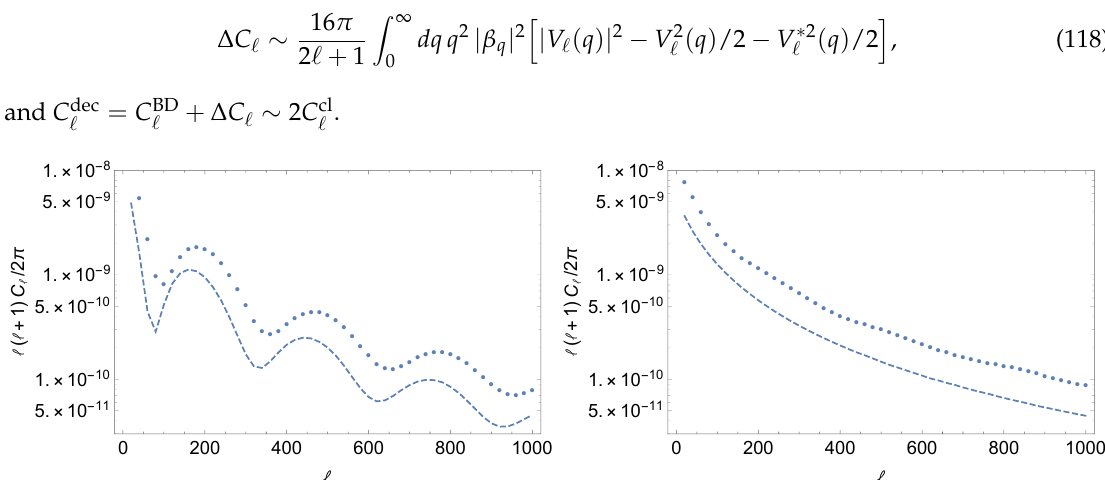
C dec (cid:96) (dotted line) with